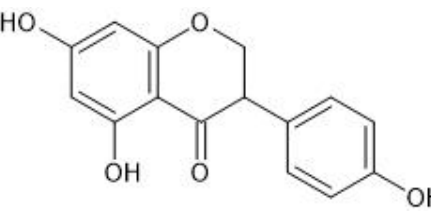
Figure 1. Chemical structure of isoflavones.